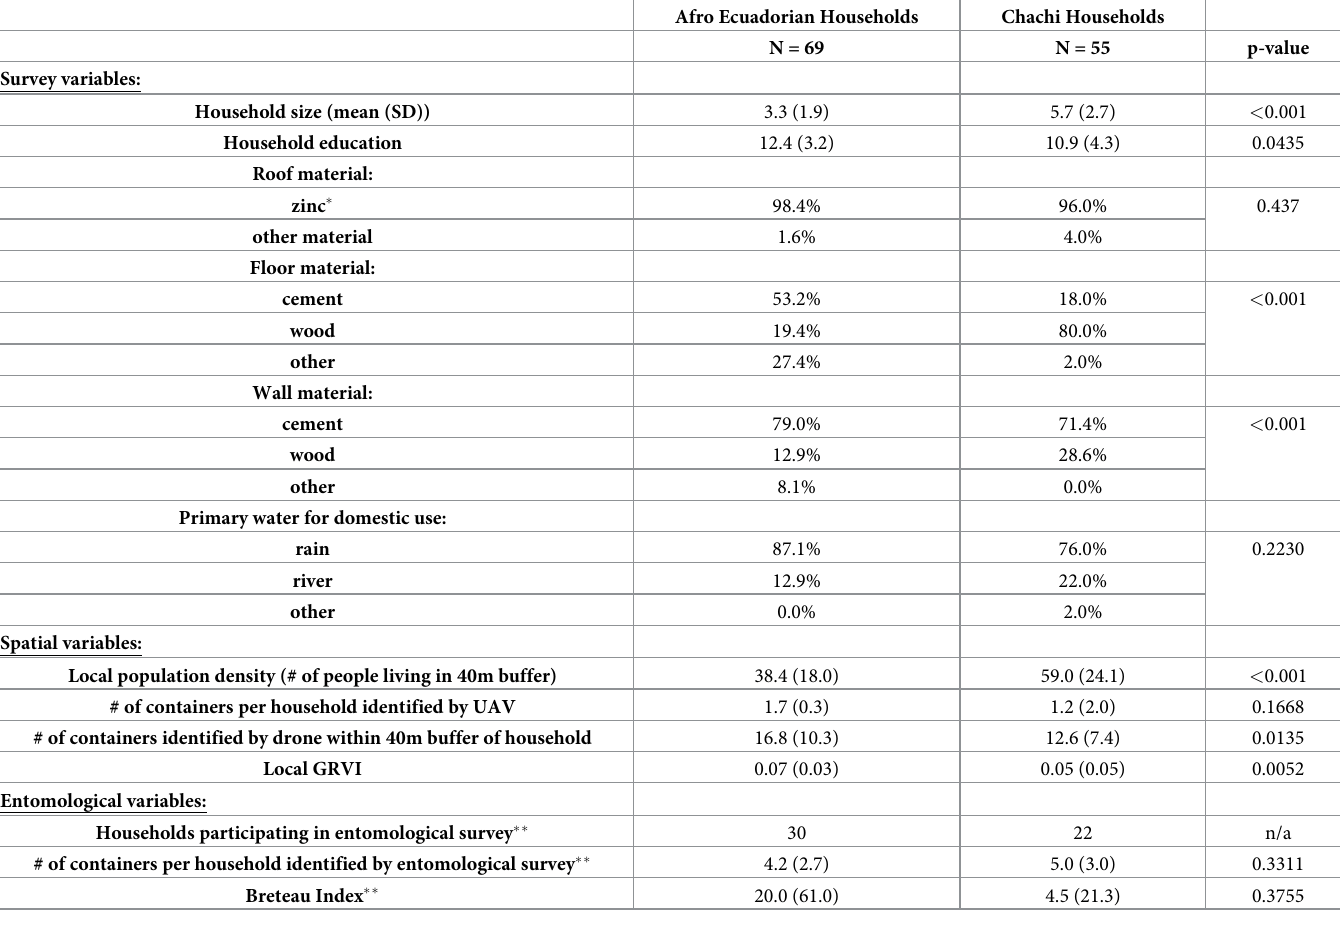
Table 1. Comparison of Afro Ecuadorian and Chachi Households. Four households that described themselves as mestizo were excluded. Afro Ecuadorian Households Chachi Households